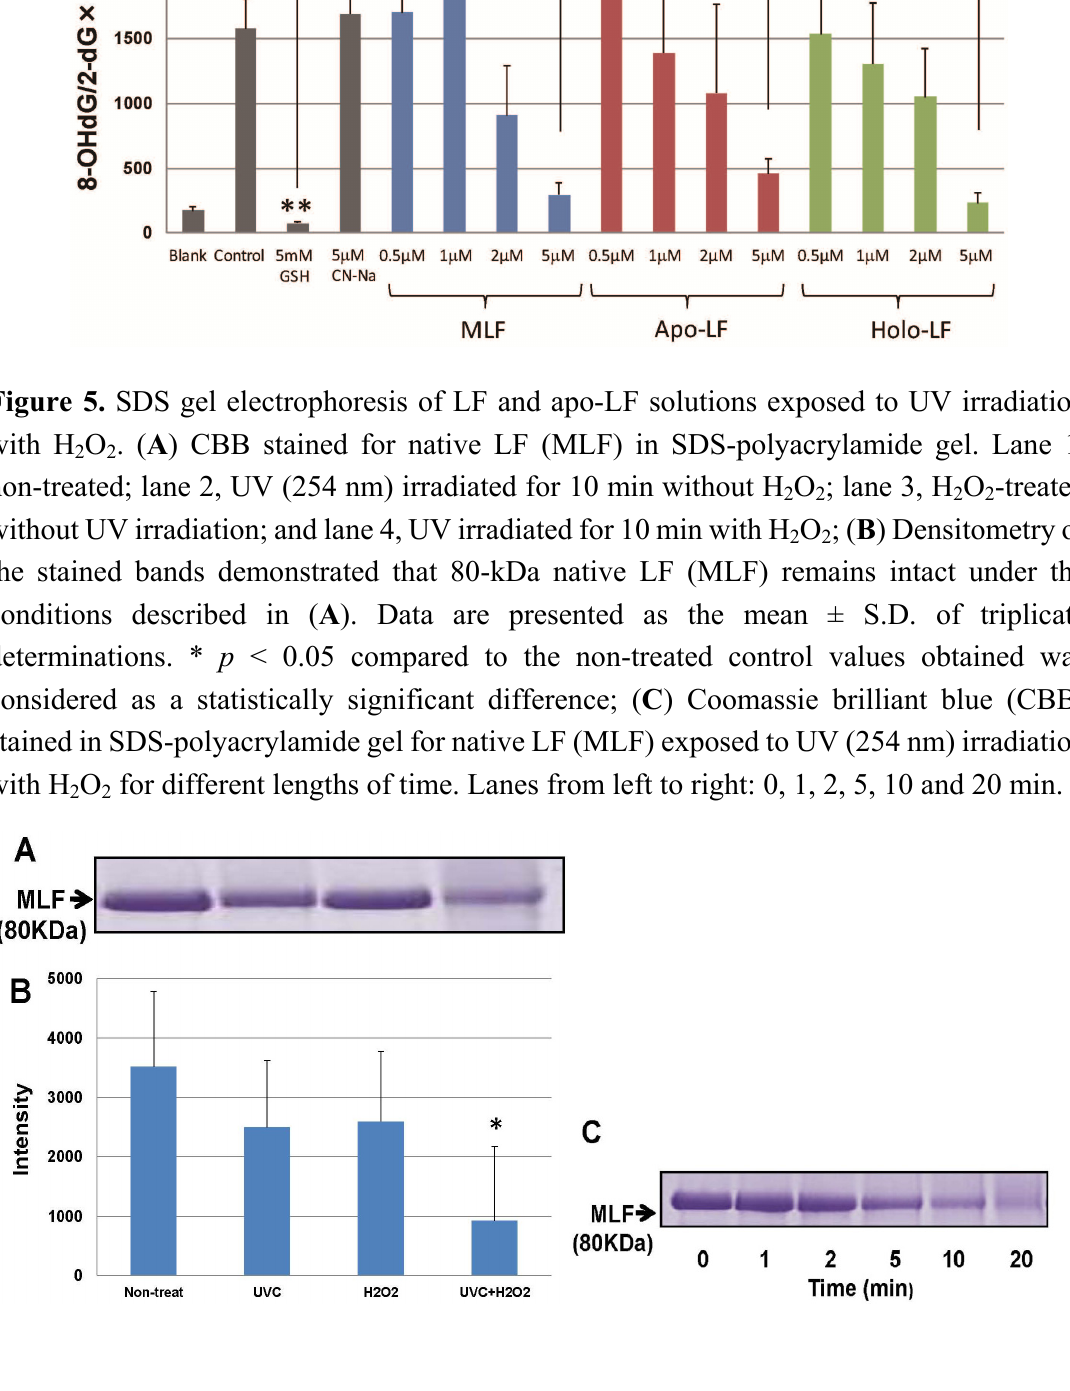
Figure 4. Effects of LFs on 8-OHdG formation following exposure to •OH generated by the UV-H O system. 8-OHdG formation in calf thymus DNA following UV irradiation 2 2 (254 nm) in the presence of H O was determined as described in the Materials and Methods 2 2 Section. Reactions with or without LFs were conducted for 5 min at room temperature. Data are presented as the mean ± S.D. of triplicate determinations. ** p < 0.01 compared to the control value obtained was considered as a statistically significant difference.